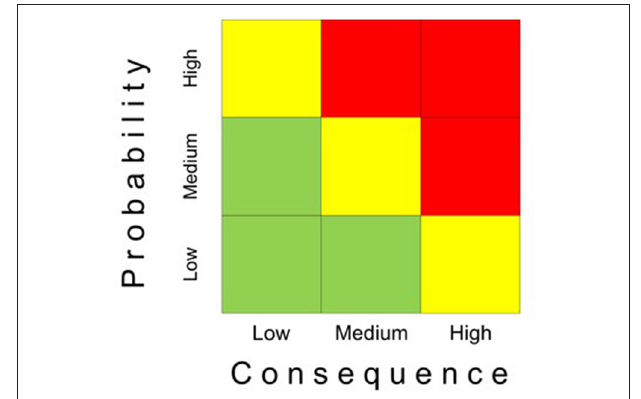
FIGURE 6 | Schematic guide for quantitative risk